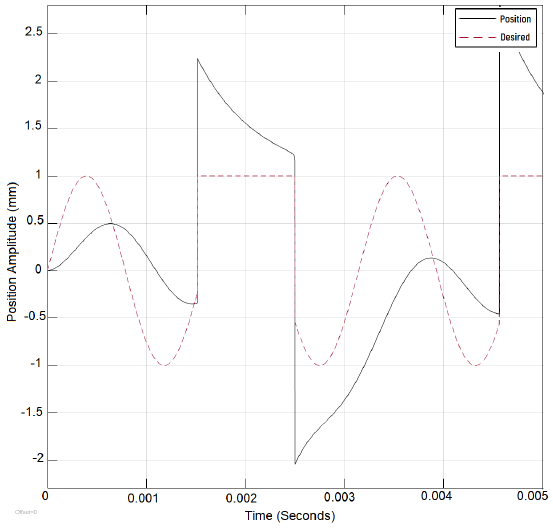
Figure 10. The position with reference to a combined signal of sinusoidal and step function under PID control.